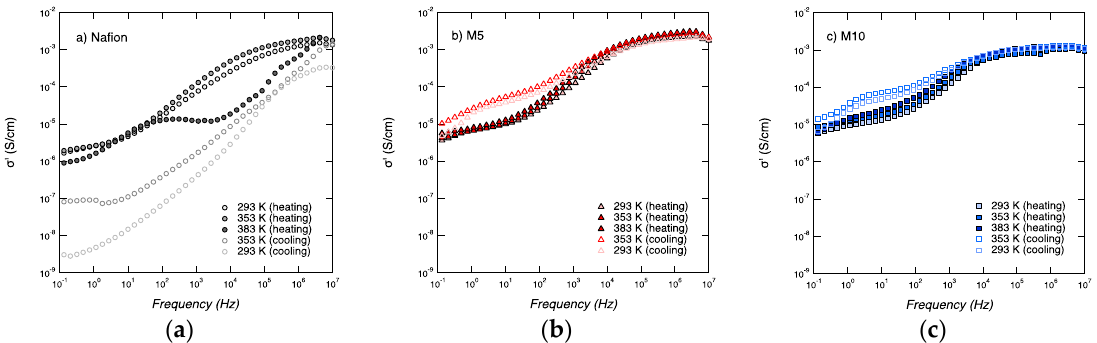
Figure 7. Conductivity ( σ ’) spectra as a function of frequency for Nafion ( a ), M5 ( b ), and M10 ( c ), during heating and cooling.